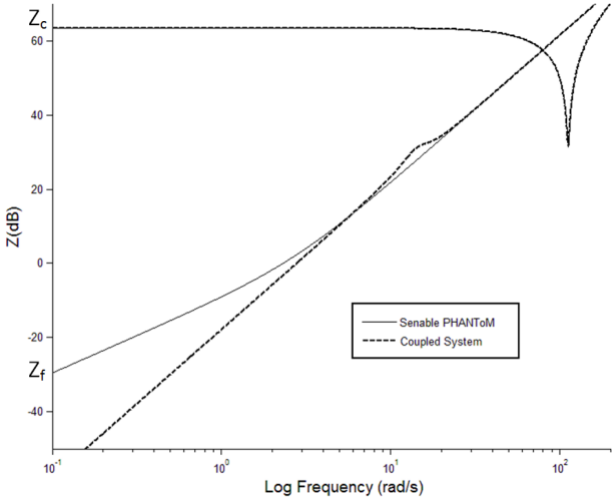
Figure 3. Approximate impedance response of the PHANToM Premium 1.5 (base rotation only) and the combined system estimated using Equations (8) and (9) respectively.